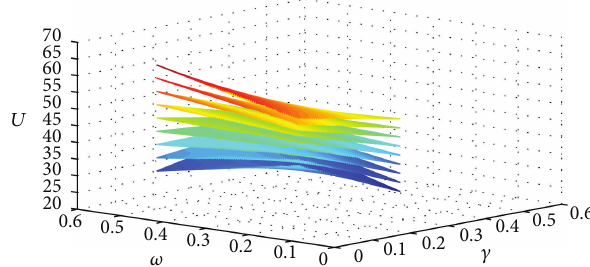
Figure 2: 9 kinds of weights assigned revenue under a system-wide weighted three-dimensional.